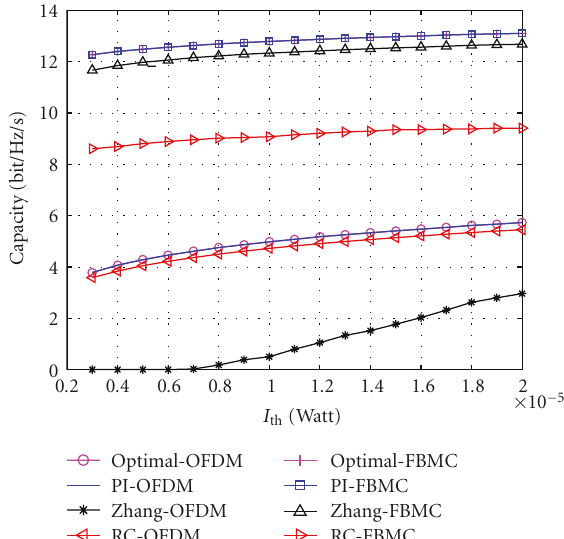
Figure 15: Achieved capacity versus allowed interference threshold (low) for OFDM- and FBMC-based CR systems—one active PU